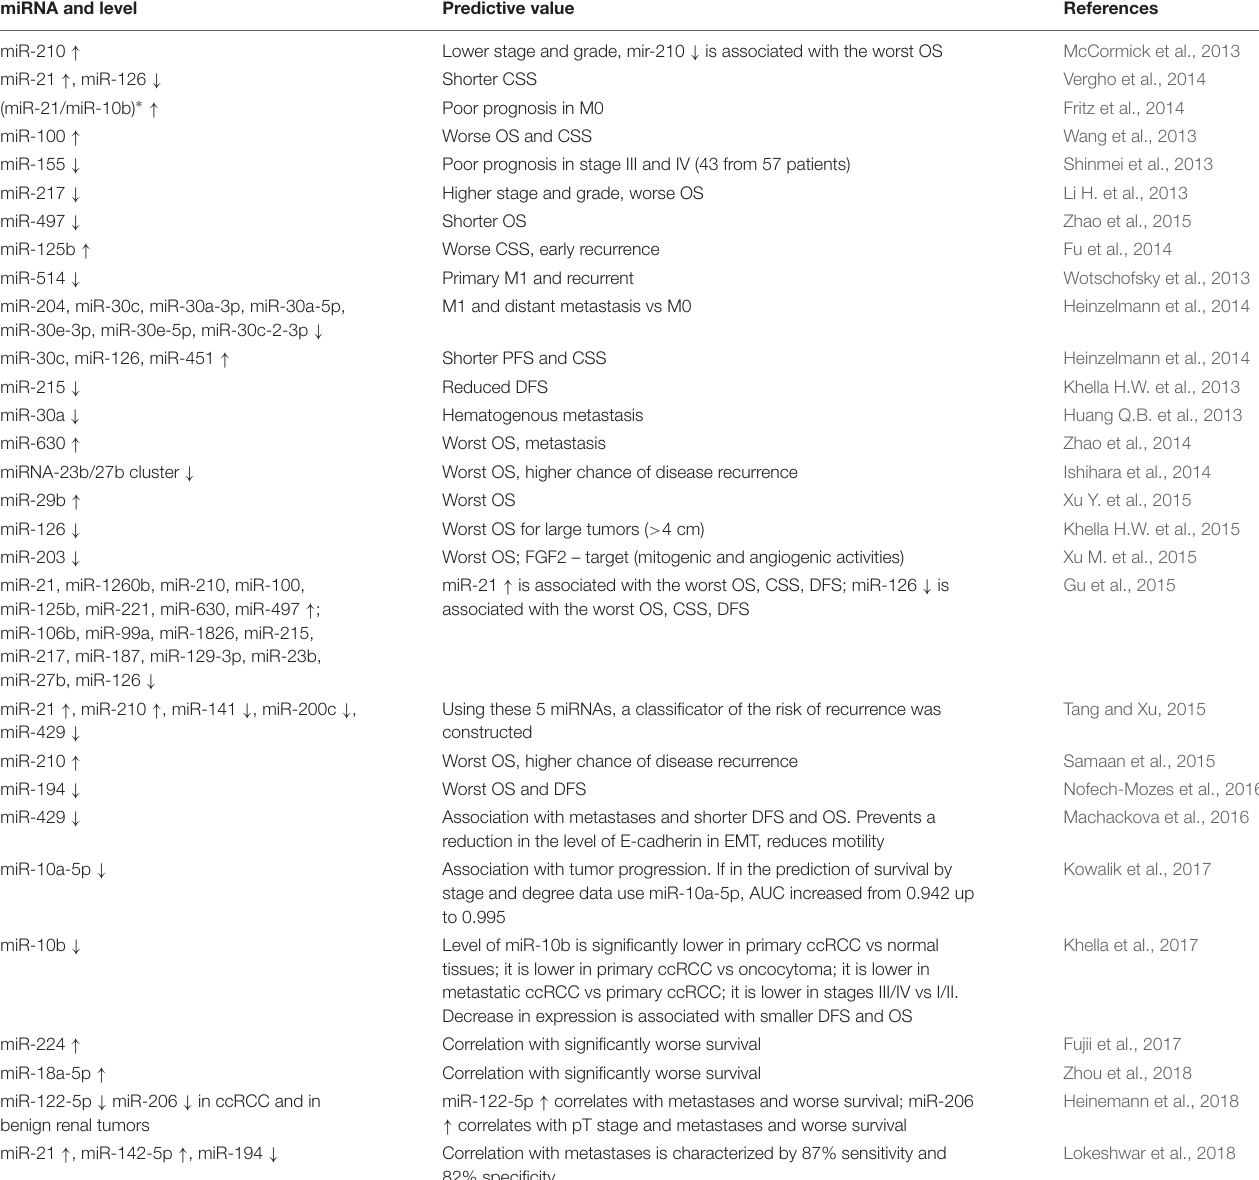
TABLE 3 | Prognostic markers for poor survival and metastasis in ccRCC: miRNA level and predictive value. miRNA and level Predictive